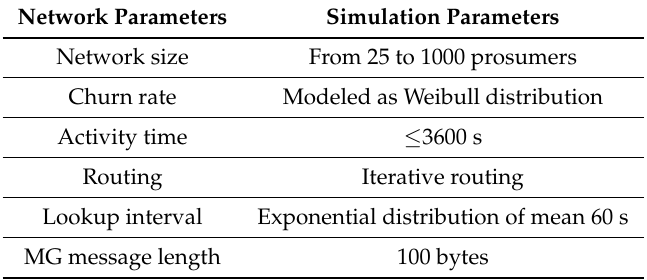
Table 5. Simulation parameters related to the specific protocols being analyzed [14,22]. MG: micro-grid.